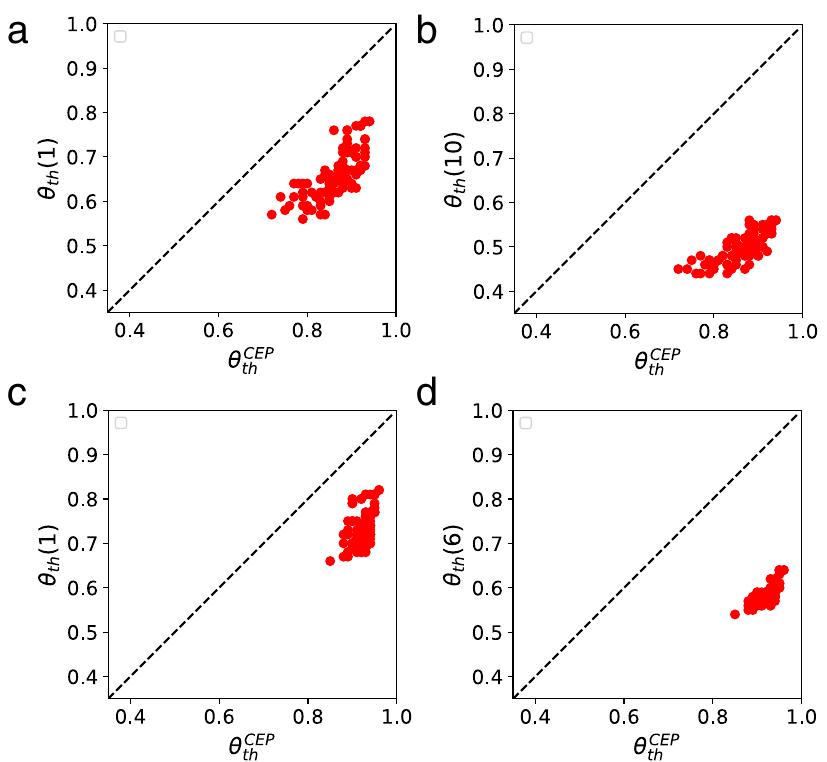
, the entanglement percolation threshold th